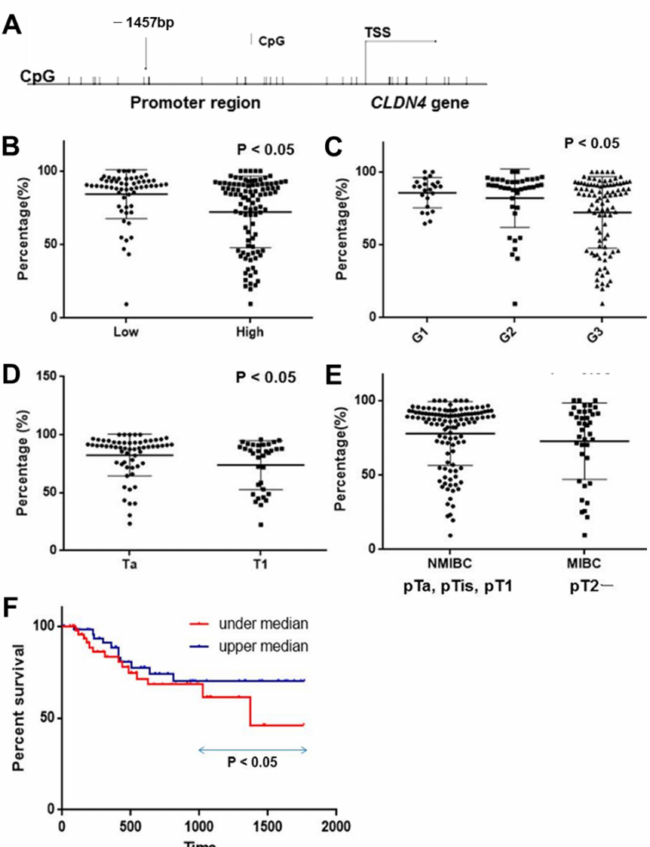
Figure 1. Hypomethylation of promoter DNA in CLDN4 gene in 157 cases of BUCs. ( A ) Examined CpG island in CLDN4 promoter region. ( B ) Comparison of CLDN4 promoter methylation between low-grade and high-grade BUCs. ( C ) Comparison of CLDN4 promoter methylation among G1, G2, and G3 BUCs. ( D ) Comparison of CLDN4 promoter methylation between pTa and pT1 BUCs. ( E ) Comparison of CLDN4 promoter methylation between NMIBCs and MIBCs. ( F ) Comparison of overall survival between CLDN4 promoter methylation low (under median) and high (upper median) cases. Grade (high, low, or G1, G2, or G3) and primary tumor (pT; pTa, non-invasive papillary BUC; pT1, invasion into subepithelial layer) are classified according to the TNM classification system [18]. The data show the mean ± SD, wherein the SD was calculated by Student’s t -test. Survival analysis was performed by Kaplan–Meier method with statistical test by generalized Wilcoxon test.